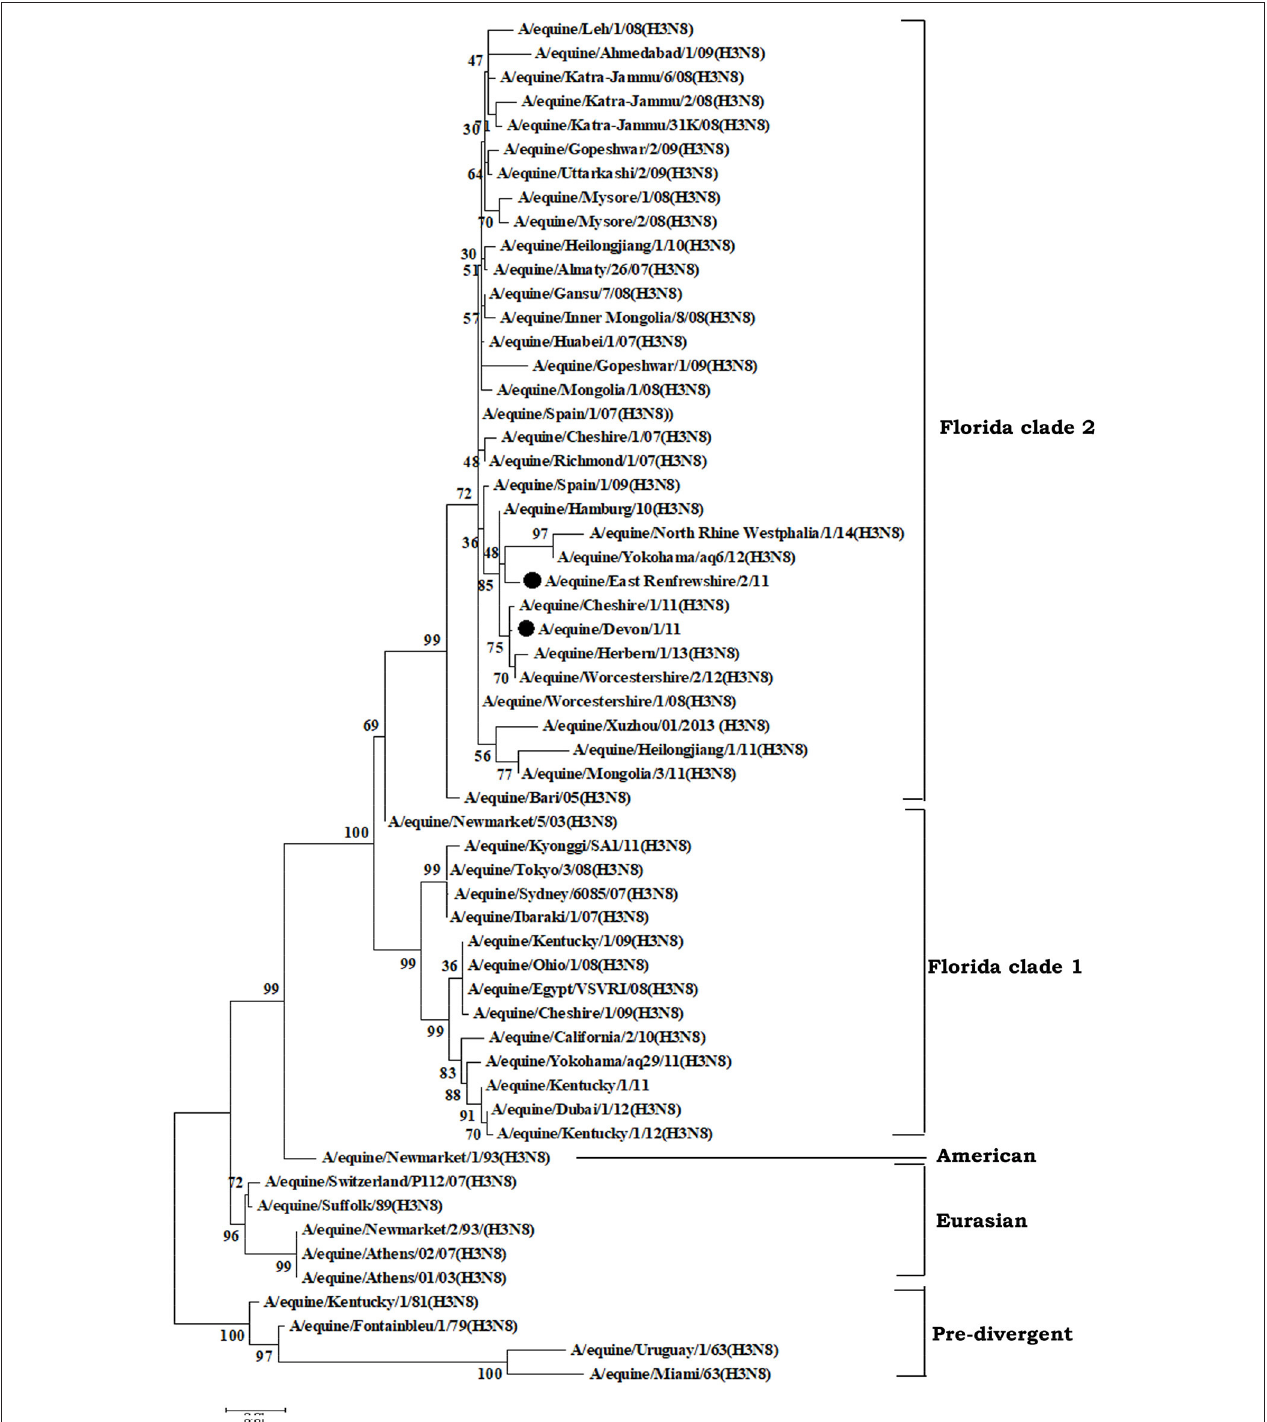
FIGURE 2 | Phylogenetic analysis of hemagglutinin (HA) genes nucleotide sequences from 57 Equine Influenza Viruses (EIVs). The maximum likelihood tree was constructed using stringent T92 + G algorithm which was identified using the find best DNA/protein model tool available in MEGA 6. The reliability of the trees was assessed by bootstrap with 1,000 replications with cut off at 50 are shown in the tree. The phylogram depicts five major clusters of global EIVs. Phylogenetic group’s viz., Florida sub-lineage clade 1, Florida sub-lineage clade 2, American, Eurasian and Pre-divergent, are mentioned by bars on the right. The major mutations (I179V and A144V) observed in the Clade 2 viruses of Florida sublineage in recent isolates have been denoted by solid dots.